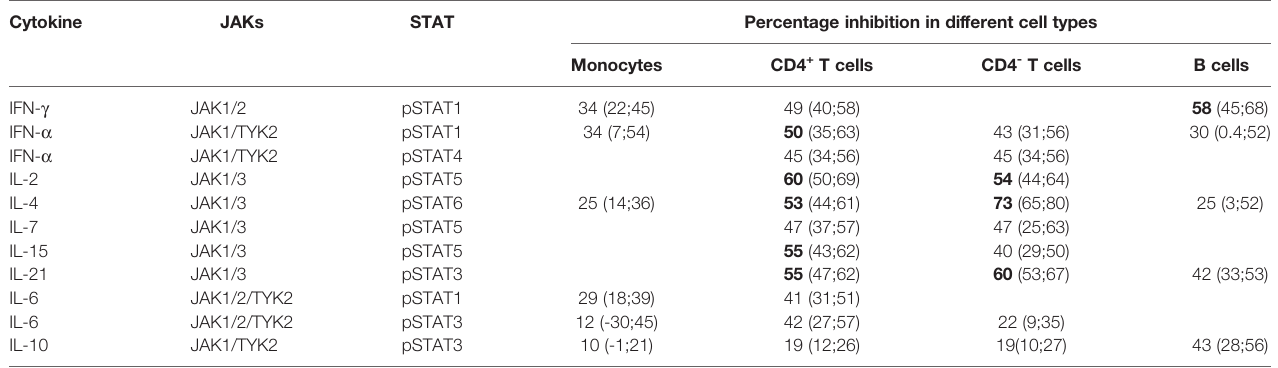
TABLE 3 | Mean (95% con fi dence interval) percentage inhibition of cytokine-induced STAT phosphorylation by tofacitinib in different cell populations at three months compared to baseline. Cytokine JAKs STAT Percentage inhibition in different cell types